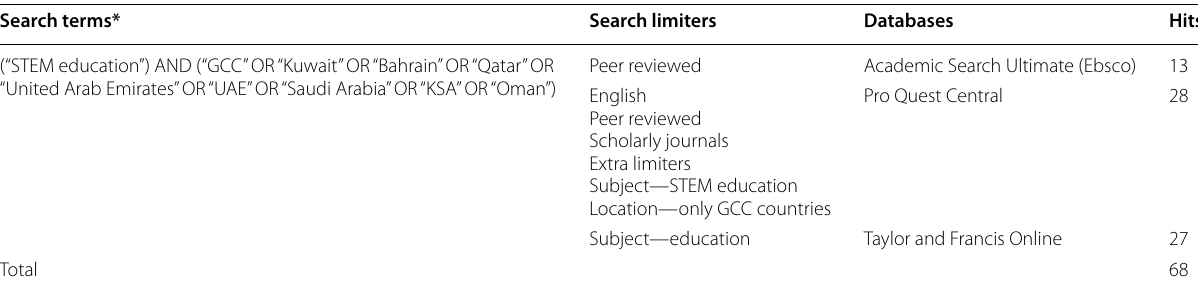
Table 1 Results of initial search